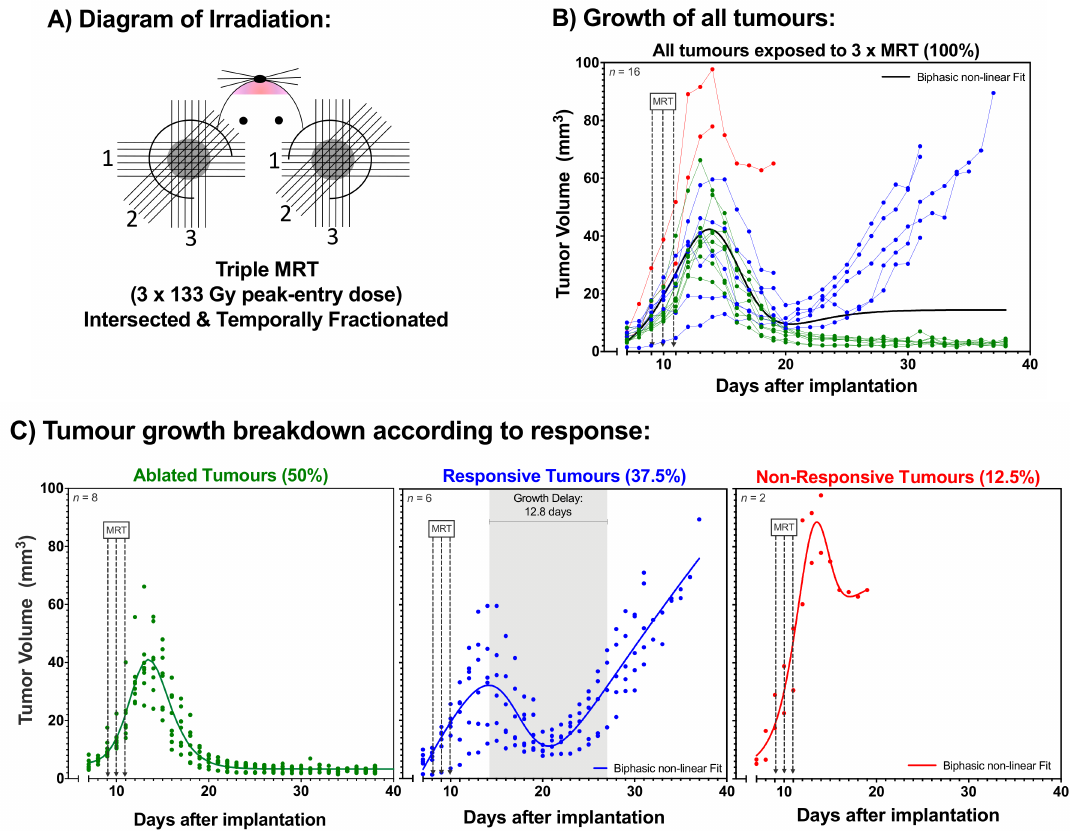
133.41 Gy). B16-F10 ×